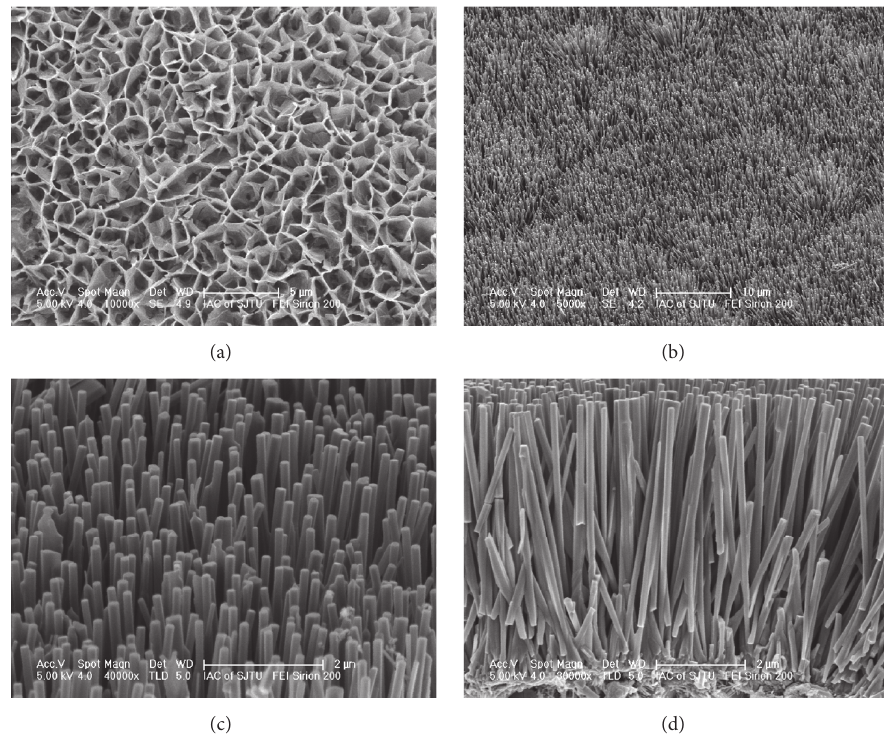
Figure 1: SEM images of the as-grown ZnO samples on the Al substrate. (a) Large-area view of the ZnO nanoflakes on the Al substrate, (b) top images of the ZnO nanorod arrays and (c) high magnification ZnO nanorod arrays, and (d) side views of the ZnO nanorod